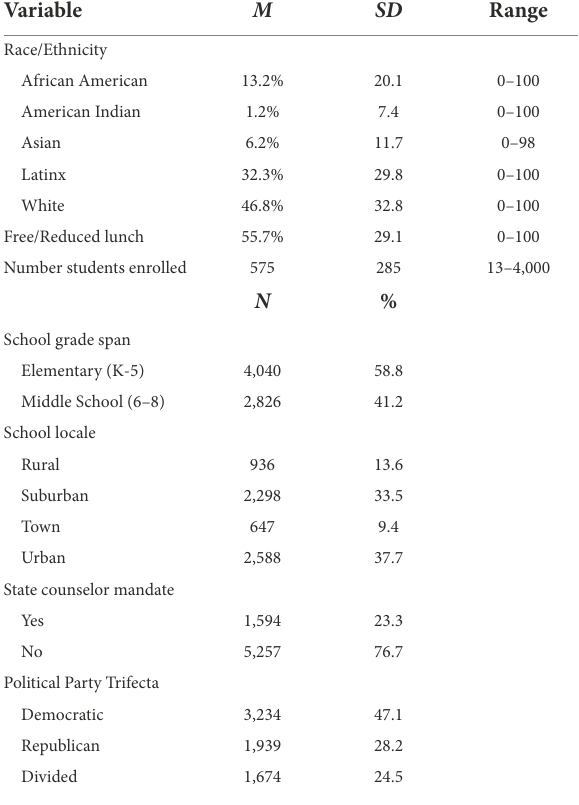
TABLE 1 Descriptive statistics school- and state-level covariates Variable